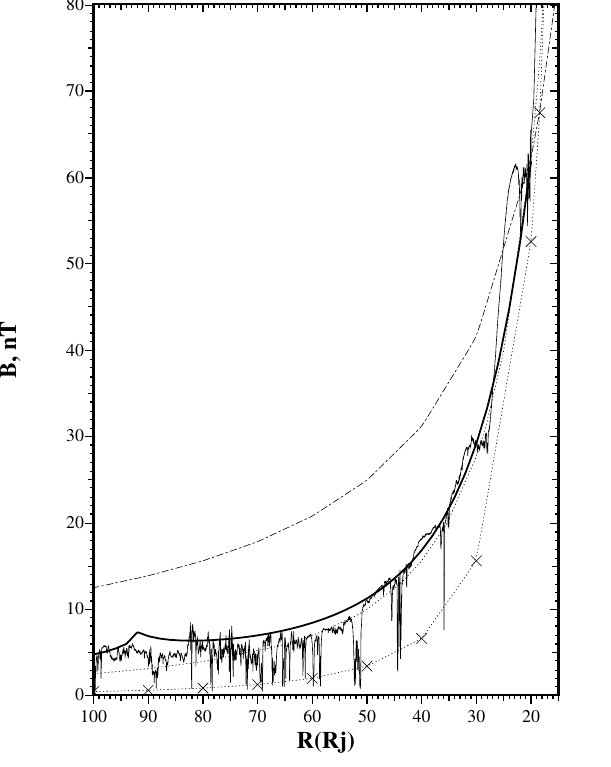
Fig. 5. Measured by Ulysses the Jovian magnetospheric magnetic field dependent on the radial distance r (Cowley et al., 1996) is marked by a solid curve. For comparison the magnetic field strength calculated by the present model (heavy curve), the r − 2 power-law (dotted curve), the r − 1 power-law (dotted-dashed curve), the r − 3 Jovian dipole power-law (dotted curve marked by crosses) are also shown. The power law curves were normalized on the measured field strength at 20 R J :62 . 2nT. Data (PI A. Balogh, Imperial College, London, UK) have been received by using COHOWEB system, NSSDC, NASA/GSFC, USA.